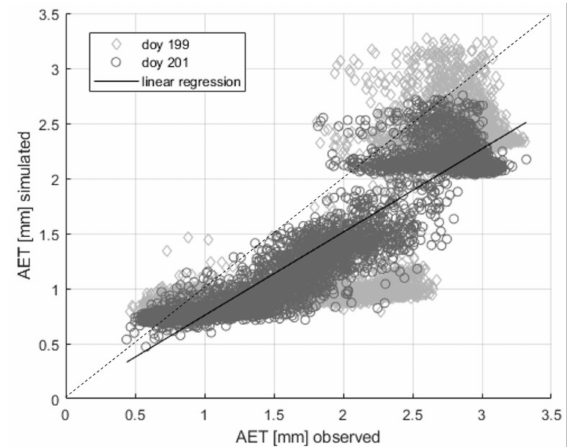
Figure 11. Comparison between AET calculated using airborne data (horizontal axis) and simulated using EnKF-SAFYswb (vertical axis), for the day of year (DOY) 199 (diamonds) and 201 (circles). The dashed line is the 1:1 simulated vs. the observed